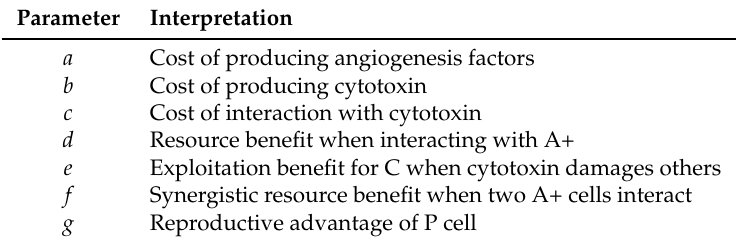
Table 1. Parameters used within the game and dynamic models.